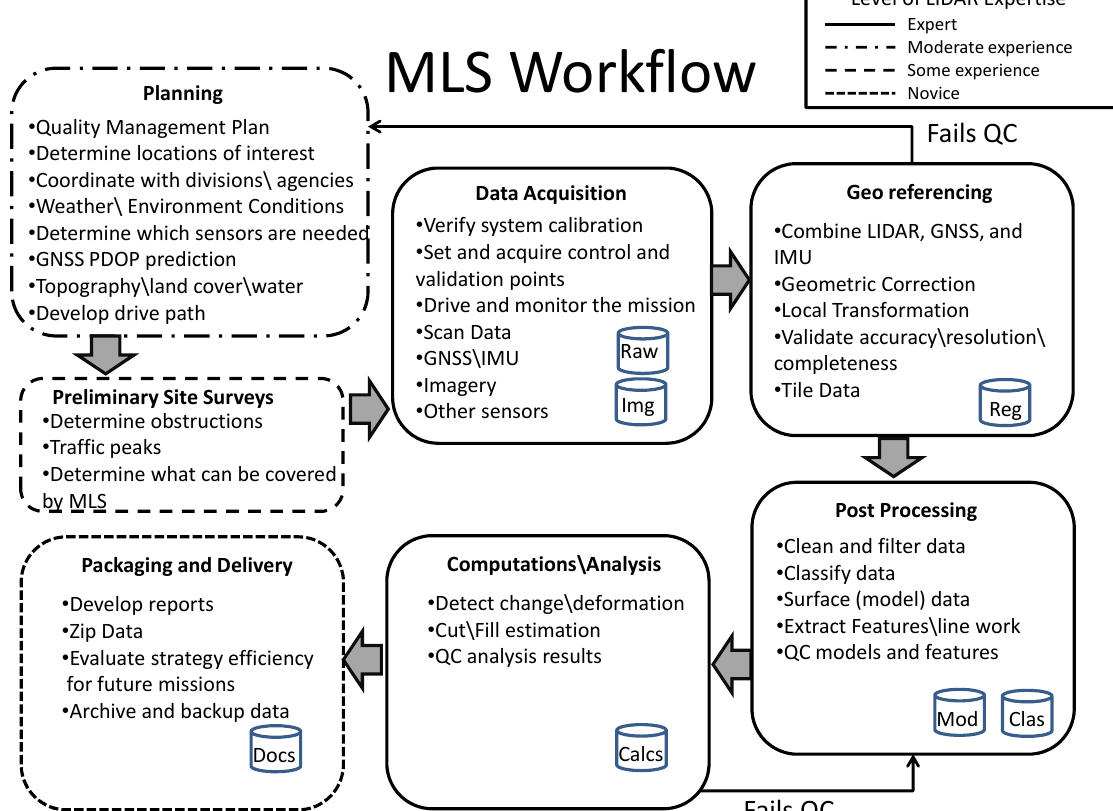
Figure 4. Generalized MLS workflow, including interim